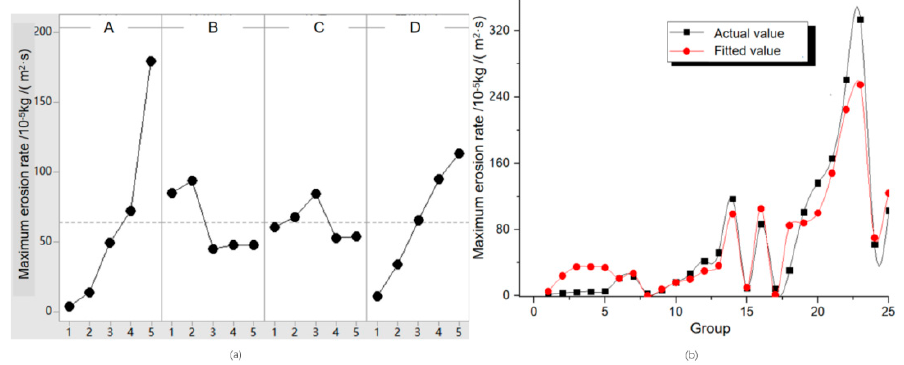
Figure 8. Main effect diagram ( a ) and regression equation data comparison diagram ( b ).